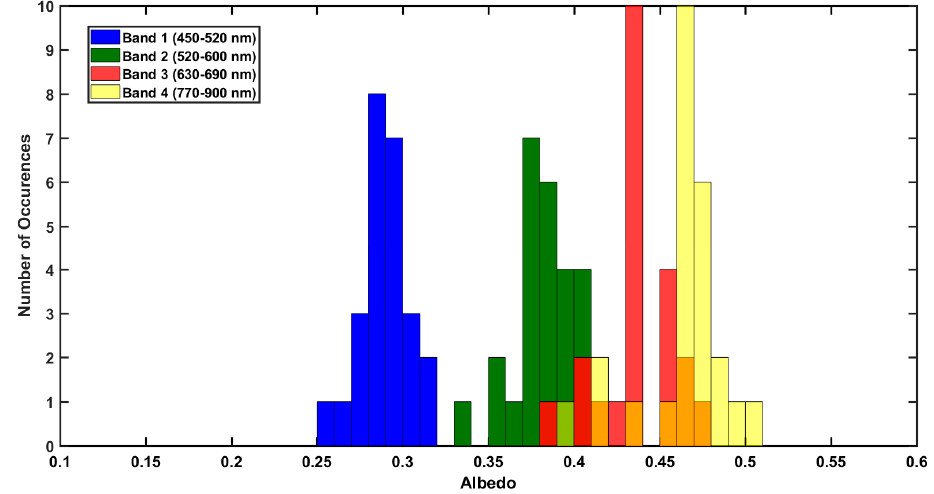
Figure 13. Histogram of neighboring LANDSAT7 ETM+ pixels over road location on 5 October 2017.